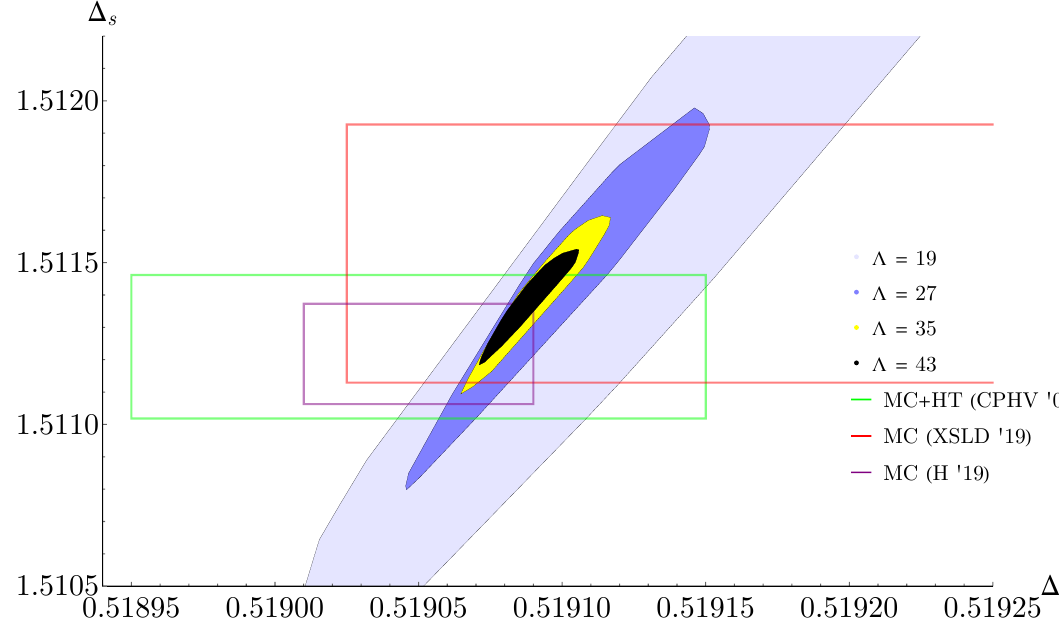
Figure 10 . New O(2) islands using the f (cid:30) i ; s; t ij g system and OPE scans at (cid:3) = 19 ; 27 ; 35 ; 43. This plot shows the projection to the f (cid:1) (cid:30) ; (cid:1) s g plane. The results are compared with the